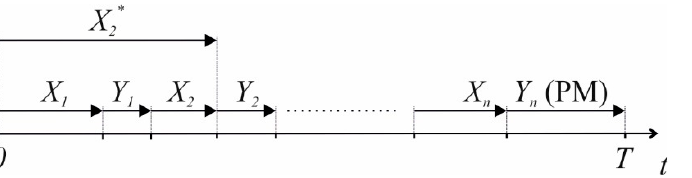
Figure 1. The first renewal cycle. The time from the beginning of the renewal cycle to the occurrence of the second failure is a random variable 𝑋 (cid:2870)∗ = 𝑋 (cid:2869) + 𝑌 (cid:2869) + 𝑋 (cid:2870) , etc. The renewal cycle T is terminated by the n-th failure and followed by the replacement. The replacement time is the random variable 𝑌 (cid:3041) .